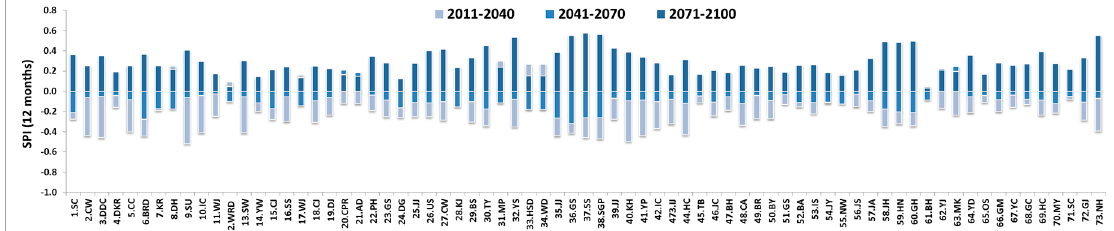
Figure 8. Results of drought index at each observatory using SPI.